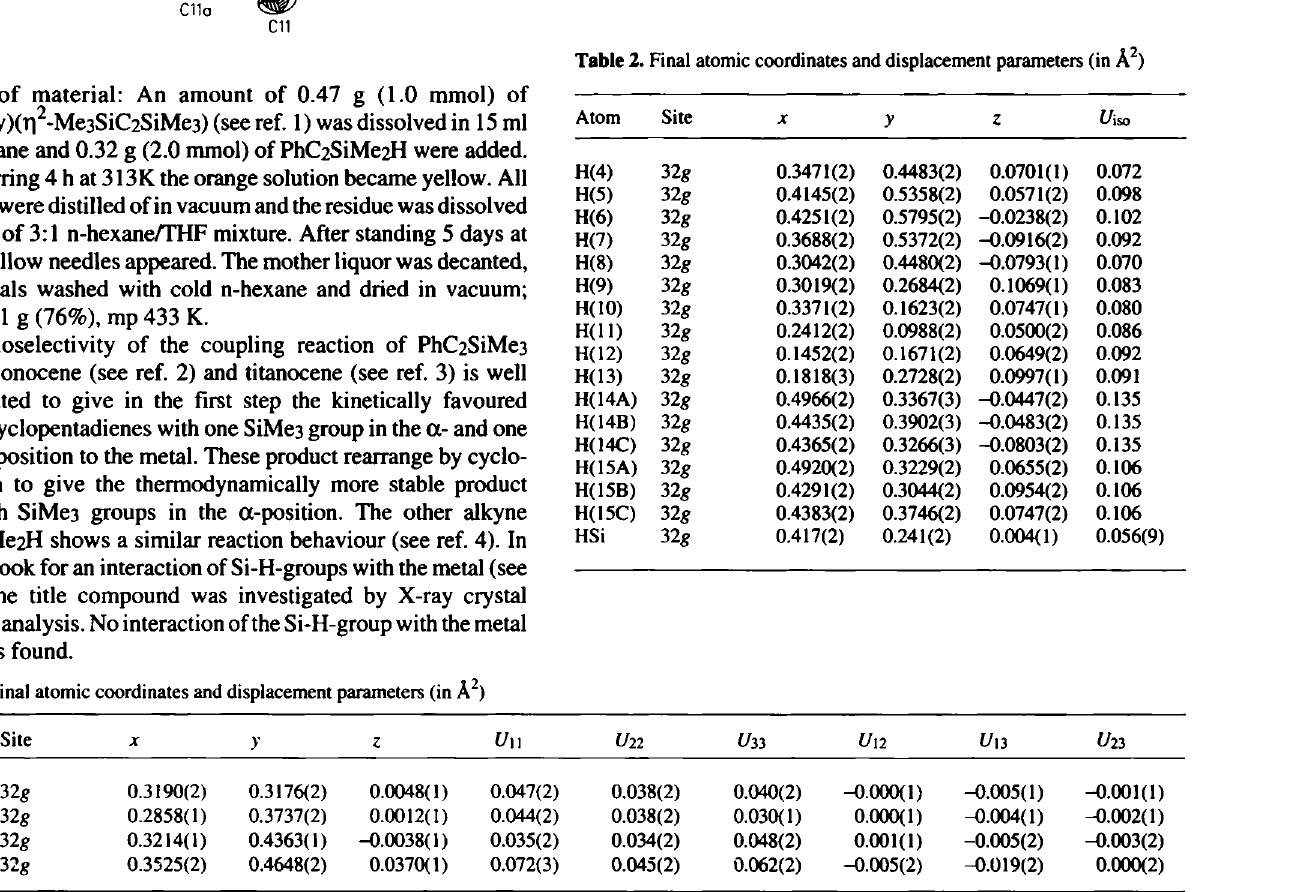
Table 3. Final atomic coordinates and displacement parameters (in Â^)